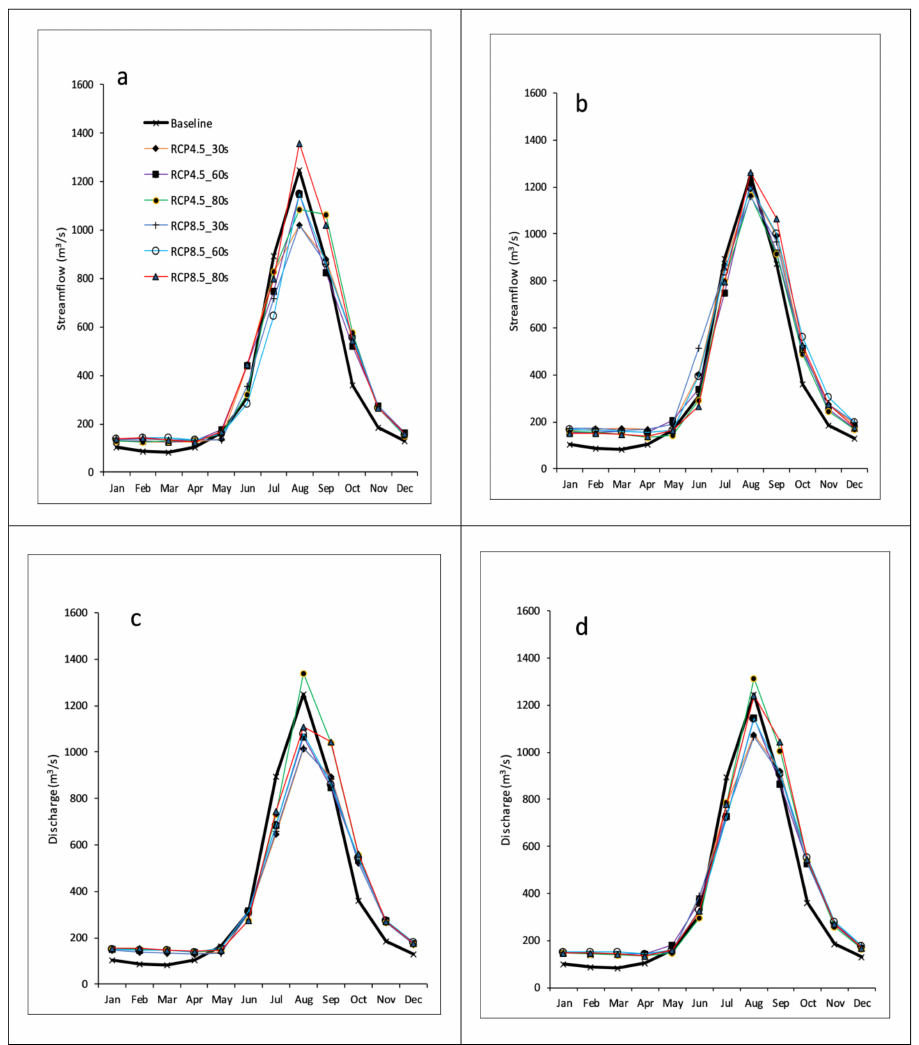
Figure 11. Comparison of the monthly mean streamflow between the observed (1975–2005) and the projected periods. ( a ) BCC-CSM1.1; ( b ) CCSM4; ( c ) MIROC-ESM; and ( d )